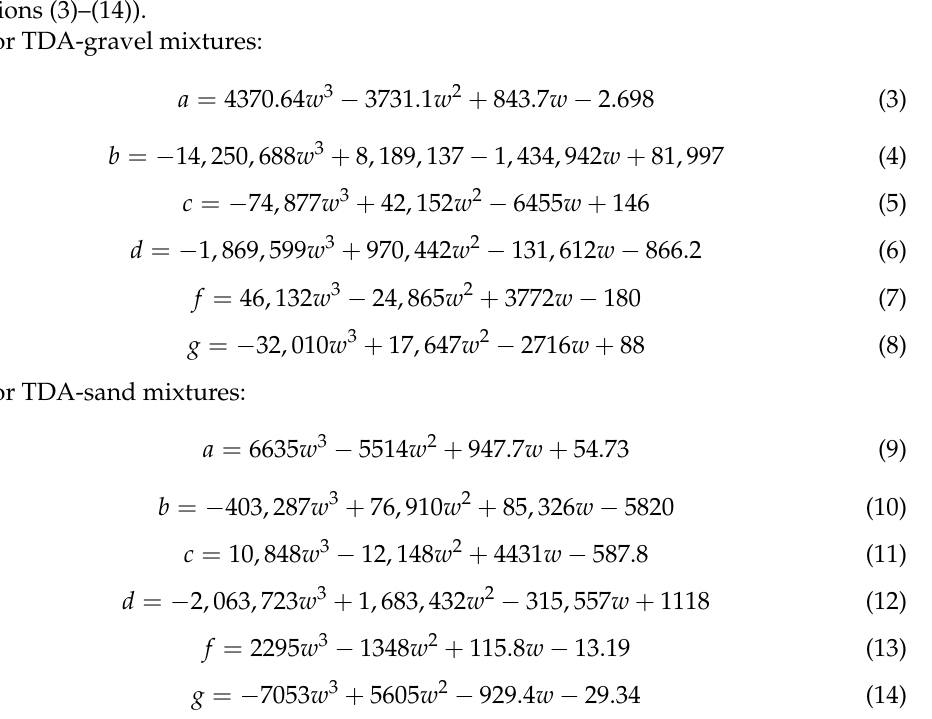
Figure 10. Comparison between laboratory and empirical equation results for sand mixtures.